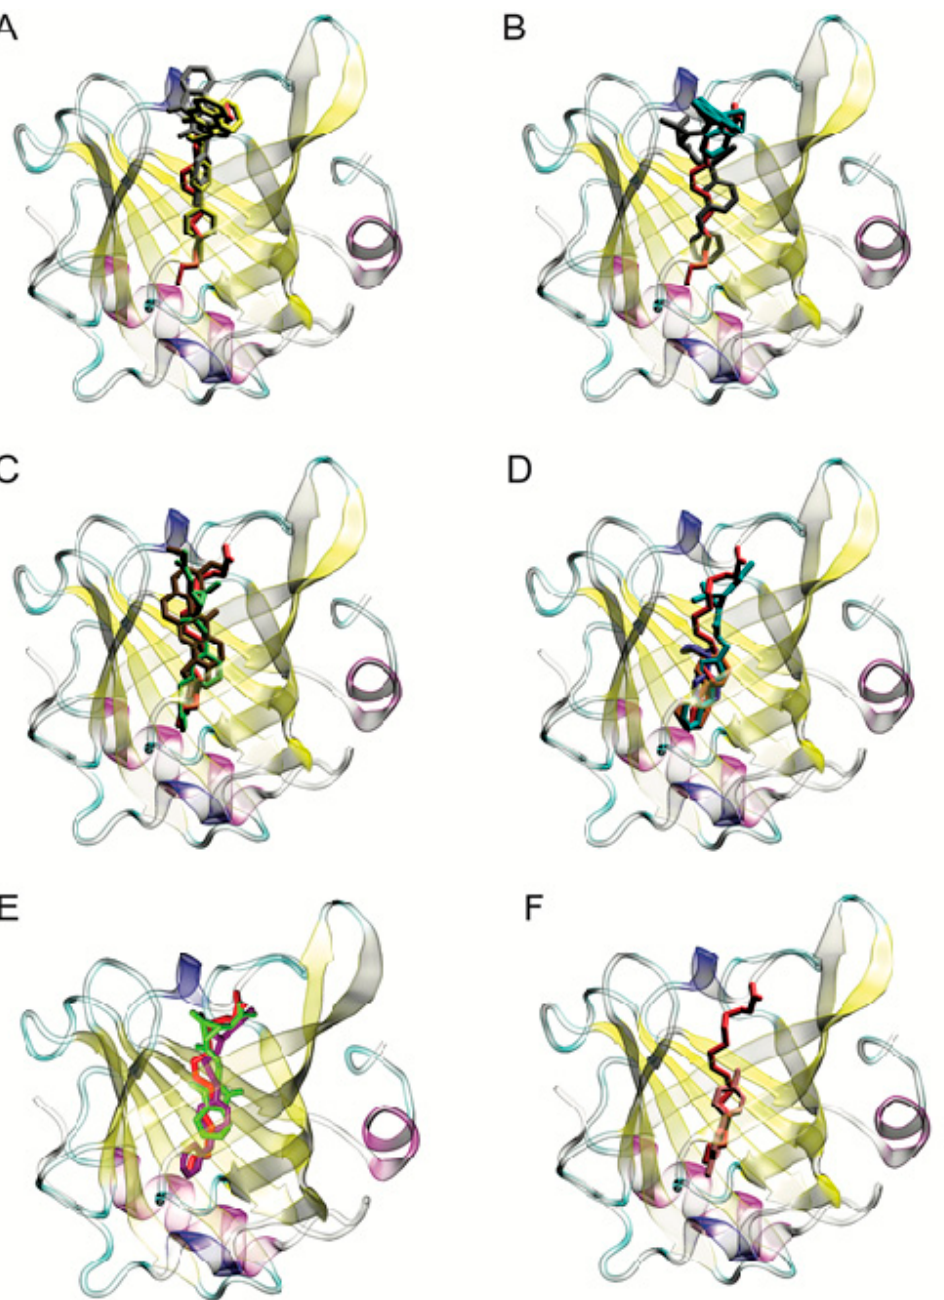
Figure 3. The position of representative pesticides in the BLG calyx, after docking. Eleven representative pesticides identified as “probable ligands” are shown, ordered by class, as in Table 1: ( A ) class Ia, bromadiolone (yellow) and chlorophacinone (gray); ( B ) class Ib, cypermethrin (black) and coumatetralyl (teal); ( C ) class II, permethrin (green) and rotenone (brown); ( D ) class III, biphenyl (orange), cyclohexylbenzene (purple) and resmethrin (teal); ( E ) class U, fenoxycarb (violet) and tetramethrin (lime green). ( F ) shows paraquat, a polar pesticide not selected as a “probable ligand” (pink). Palmitate’s crystallographic position in the calyx is shown for comparison (red in all panels). All ligands are represented by